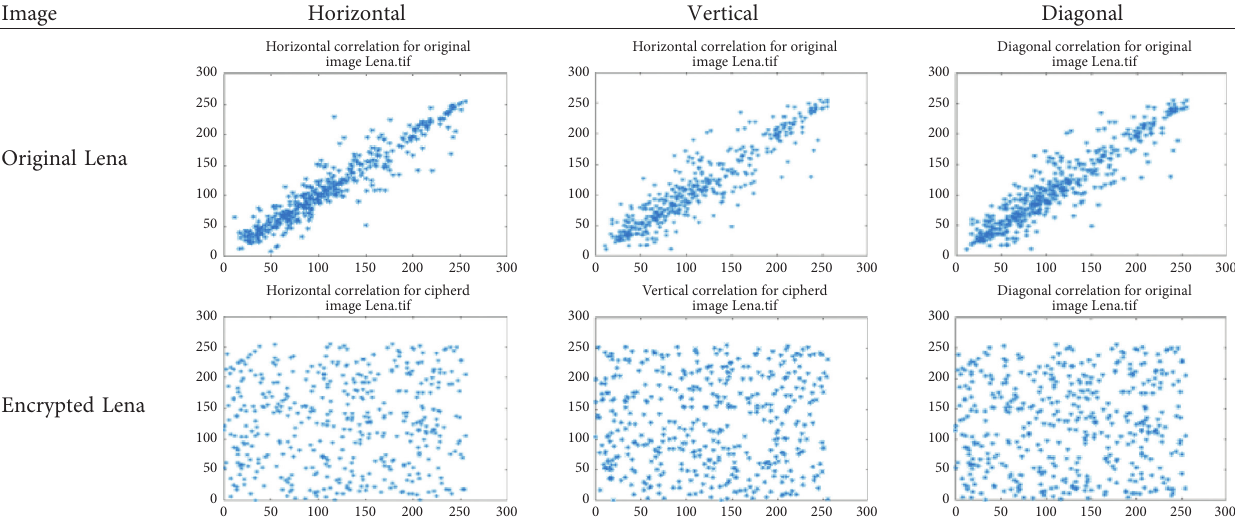
Table 4: Distribution of 2000 pairs of randomly selected adjacent pixels for the Lena image.